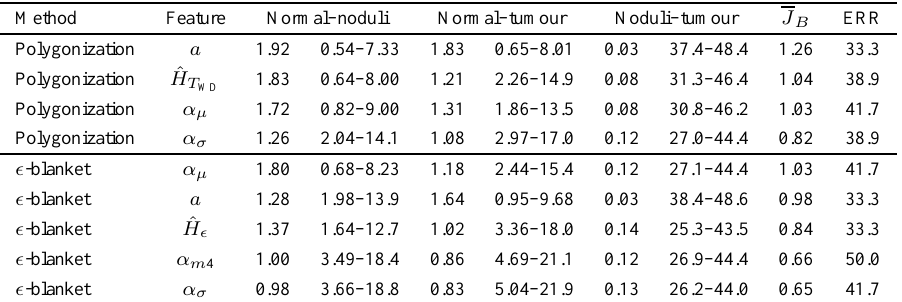
Estimated Bhattacharyya distances and lower and upper bounds of Bayes error (in %) for the best fractal features, ranked according to J B computed from Eq.